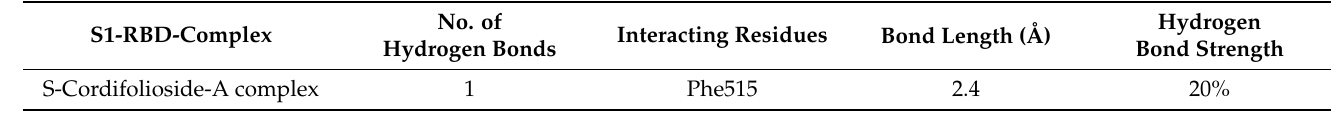
Table 3. Hydrogen-bonding analysis for S1-RBD complexes in MD